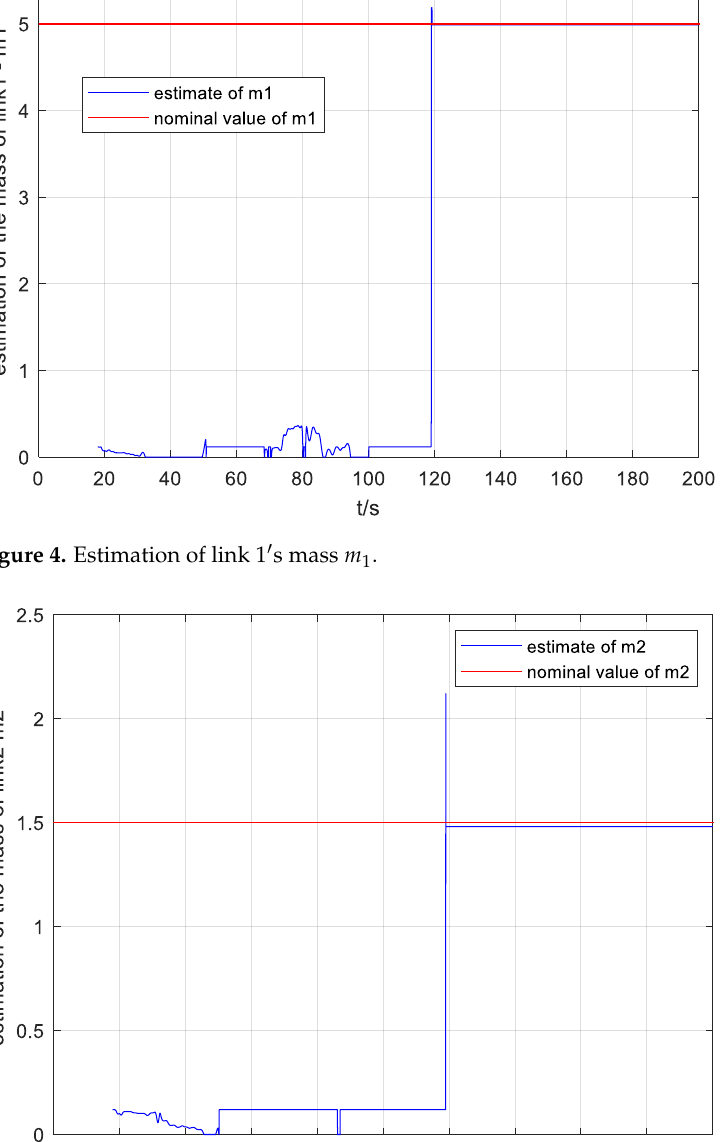
Figure 5. Estimation of link 2′s mass 𝑚 2 .